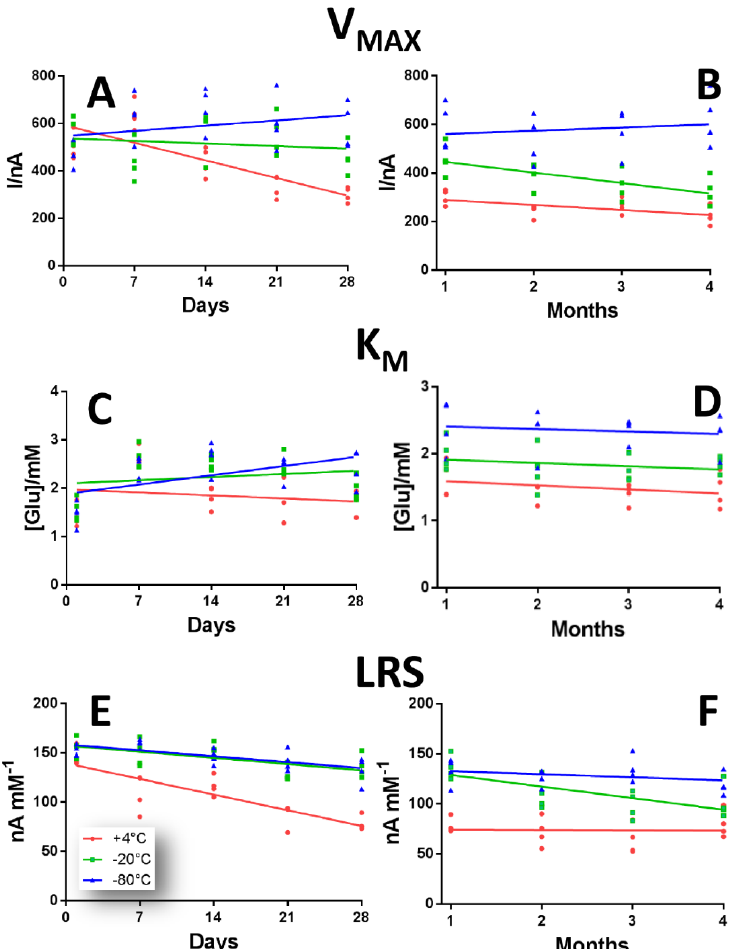
Figure 3. Scattering plot describing the variations of V MAX (Panel A and B), K M (Panel C and D) and LRS (Panel E and F), in a range of 28 days (left inset) and of four months (right inset) of GB2 design Ptc/PPD/[PEI (0.5%)-GOx]5/ GTA(1%)-BSA (2%) when stored at +4 °C (red plot), − 20 °C (green plot) and − 80 °C (blue plot).